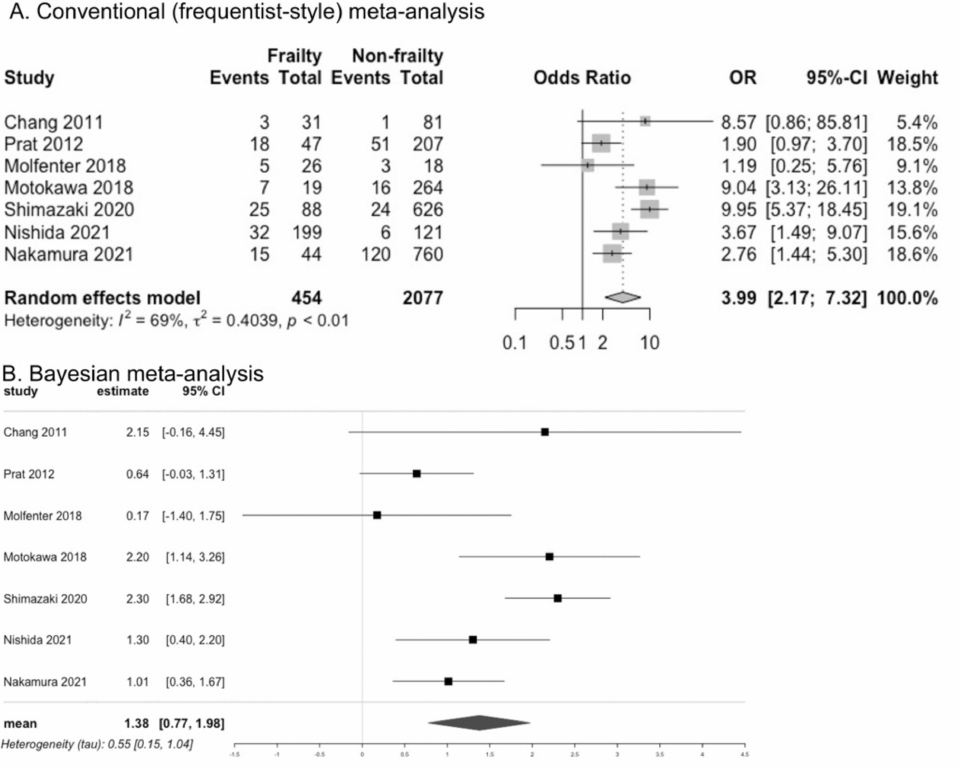
Figure 4. Comparison of presence of dysphagia between individuals with and without frailty